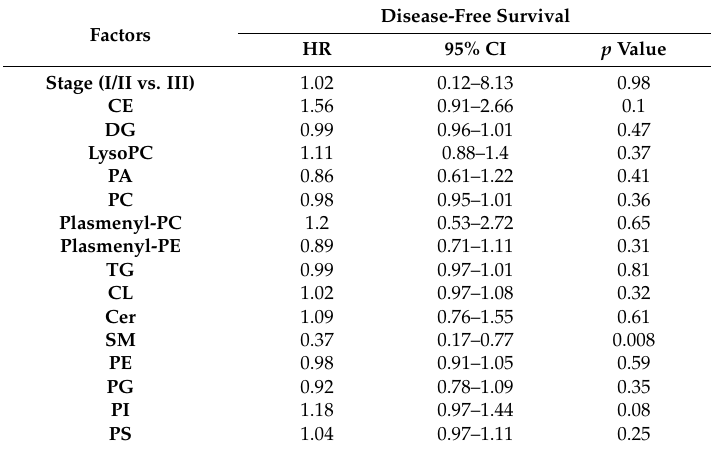
Table 3. Multivariate Cox regression analysis to identify prognostic factors in primary TNBC tumors in sphingoid base